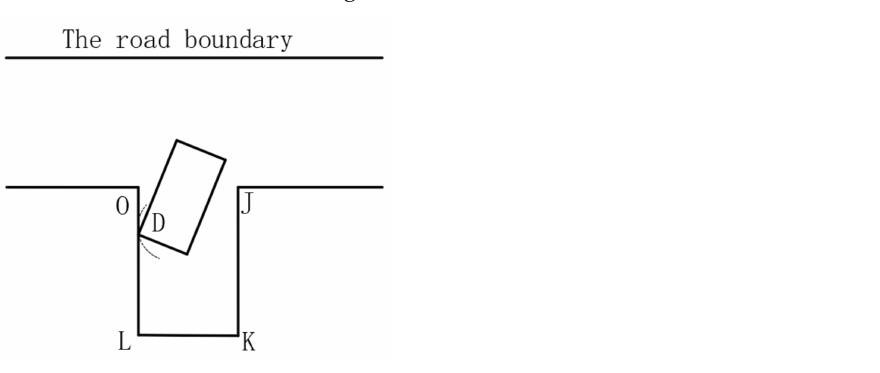
Figure 5. Collision between the rear vertex and the dimension line on the left side of the parking